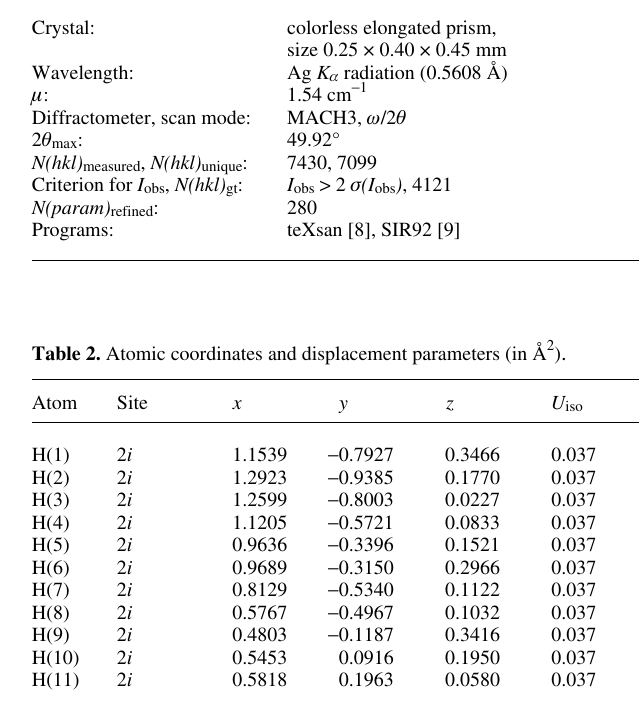
Tab le 1. Da t a c olle c t ion a nd h a ndling.